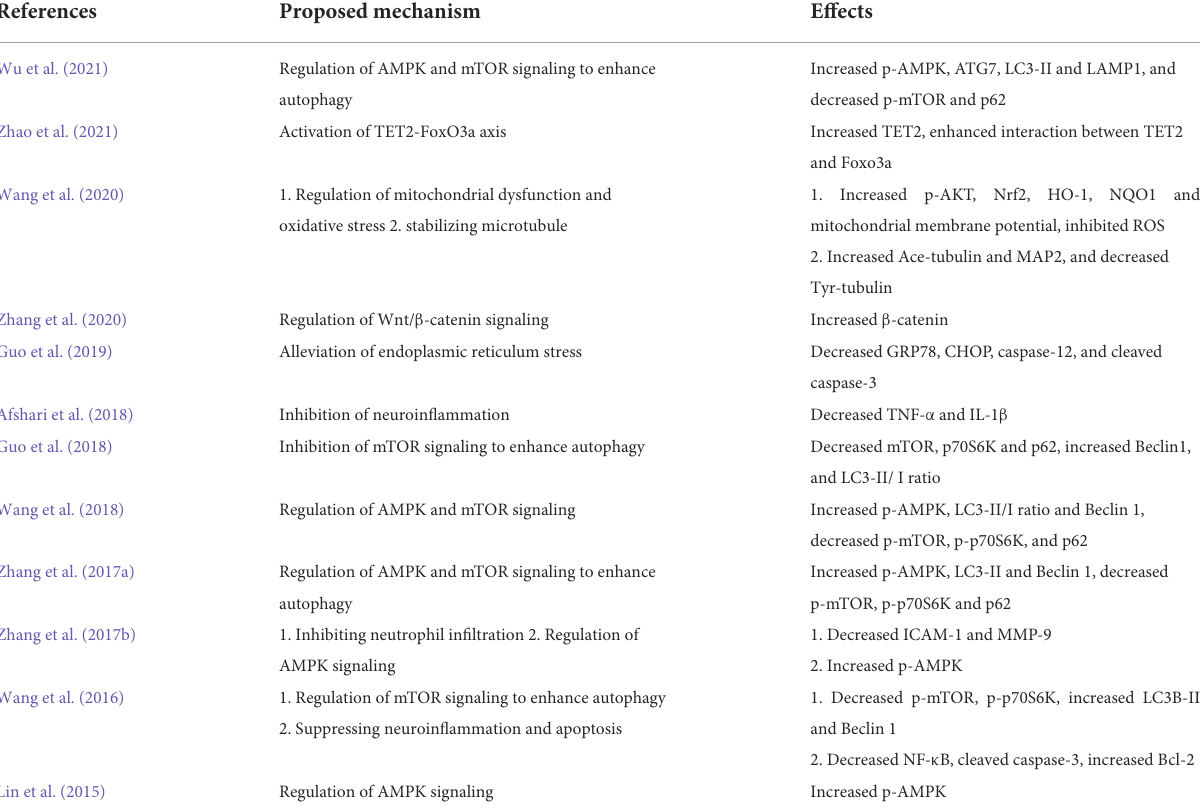
TABLE 6 The proposed mechanism of the protective effect of metformin for